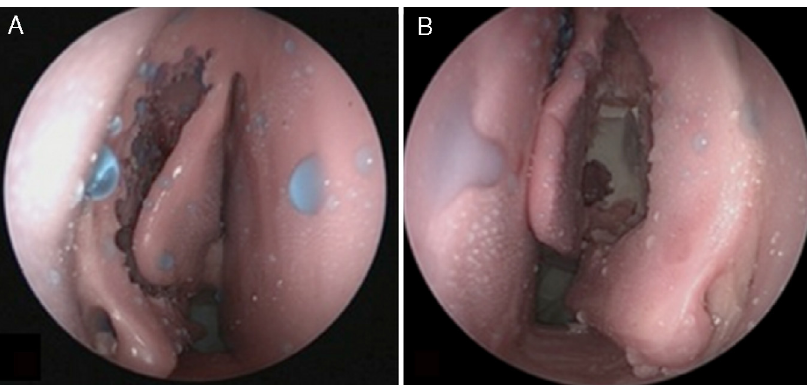
Figure 1 Model after standard dissection. (A) Middle turbinate kept with no treatment after dissection. (B) Middle turbinate sutured to the septum after dissection.